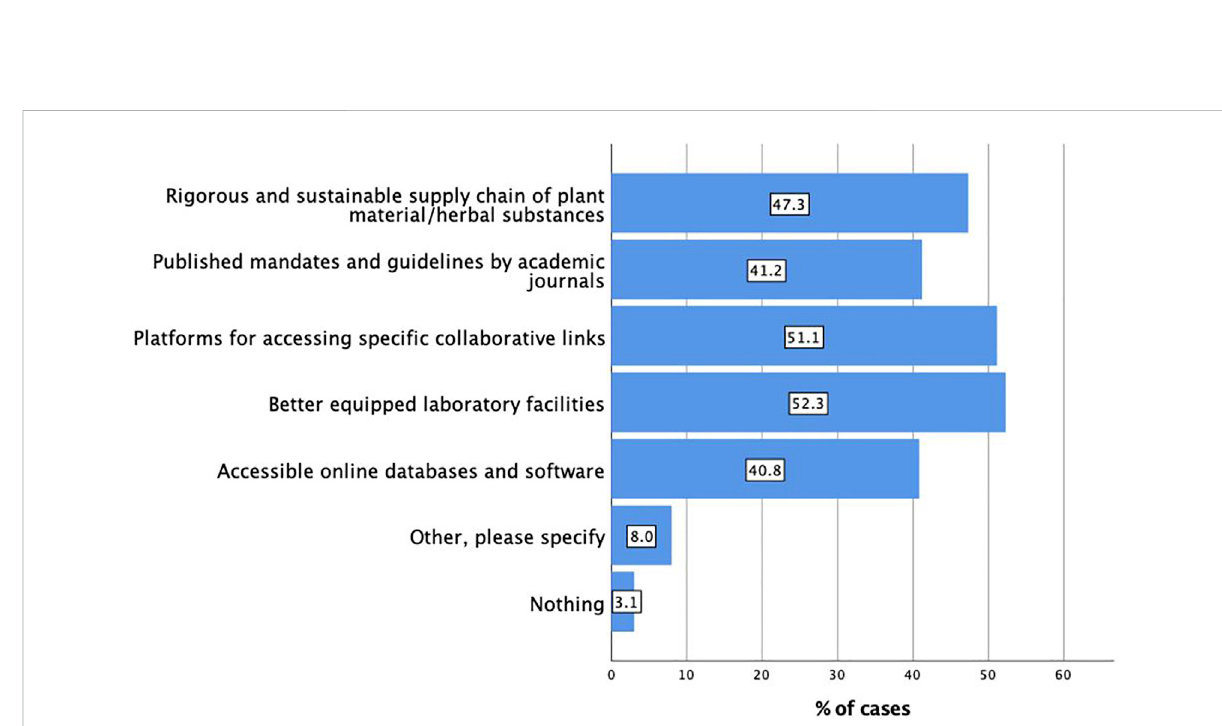
FIGURE 4 Overcoming existing core barriers in extract characterisation (n = 262; multiple responses